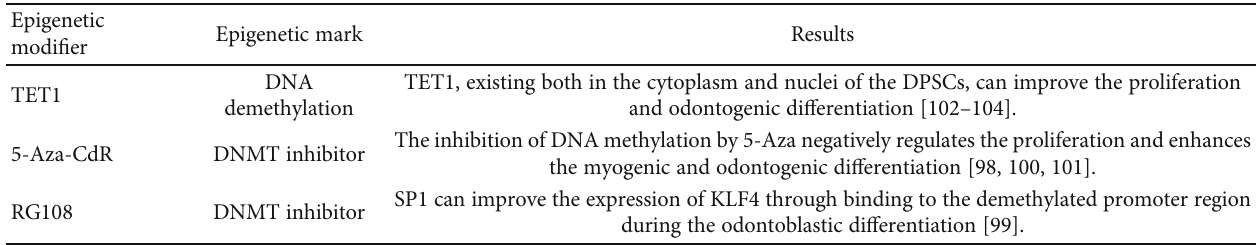
Figure 1: The multilineage di ff erentiation potential of DPSCs. DPSCs can di ff erentiate into odontoblasts, osteoblasts, cementoblasts, neural cells, myoblasts, chondrocytes, endothelial cells, adipocytes, etc. Table 1: DNA methylation in